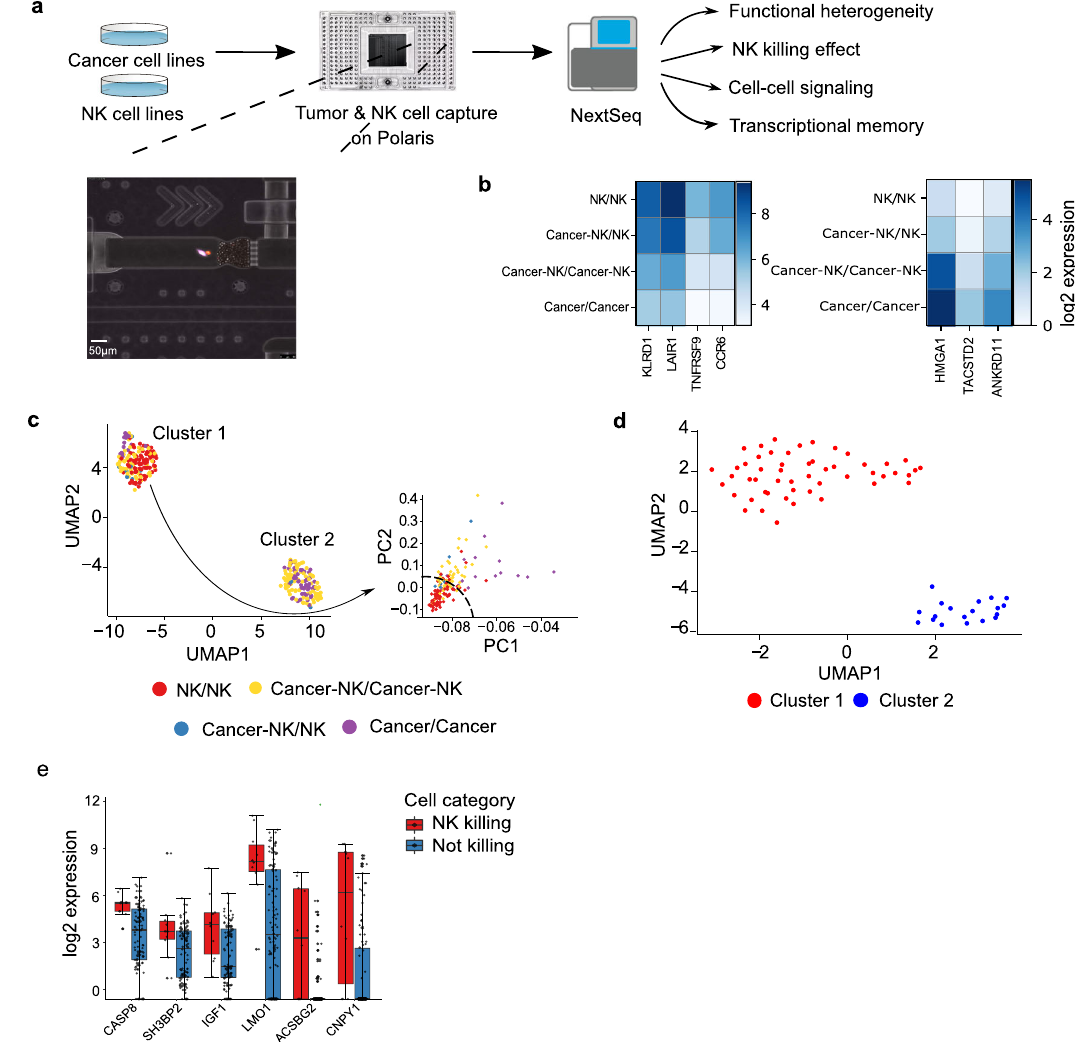
Fig. 1 Schematic work fl ow for cell interaction studies. a The work fl ow involves cancer and NK cells propagated in culture and stained off-chip, which are then captured as live single cells and doublets, incubated/co-incubated and imaged over time. Inset shows a microscopic image of a chamber on the micro fl uidic Integrated Fluidic Circuit (IFC) containing an elongated MDA-MB-231 (pink) and round NK cell (red) doublet. The cells are then lysed, reverse transcribed, and the cDNA ampli fi ed in situ within the chambers. Down-stream library preparation, sample barcoding, and sequencing are performed off- chip using the Illumina NextSeq system. b Heatmap plotted using Scanpy showing average expression of marker genes for single NK and cancer cells, con fi rming their lineage identity. c UMAP-based visualization of the cells shows two separate clusters mainly due to cancer cell line heterogeneity (cancer cells in purple). A further dimension reduction of cluster 1 using PCA shows the separation of cancer (purple) and NK cells (red). Legend key indicates cell status at the beginning and the end of the time-course tracking (e.g., cancer-NK/NK denotes interactions which initially consisted of both cancer and the NK cells in a chamber, and subsequently the NK cell remained in the chamber after co-incubation due to a cell killing event). d UMAP based visualization of single cancer cells showing heterogeneous populations of cancer cell lines. e Boxplots showing selected differentially expressed genes distinguishing killing vs non-killing events. Parts of ( a ) were created using an icon from